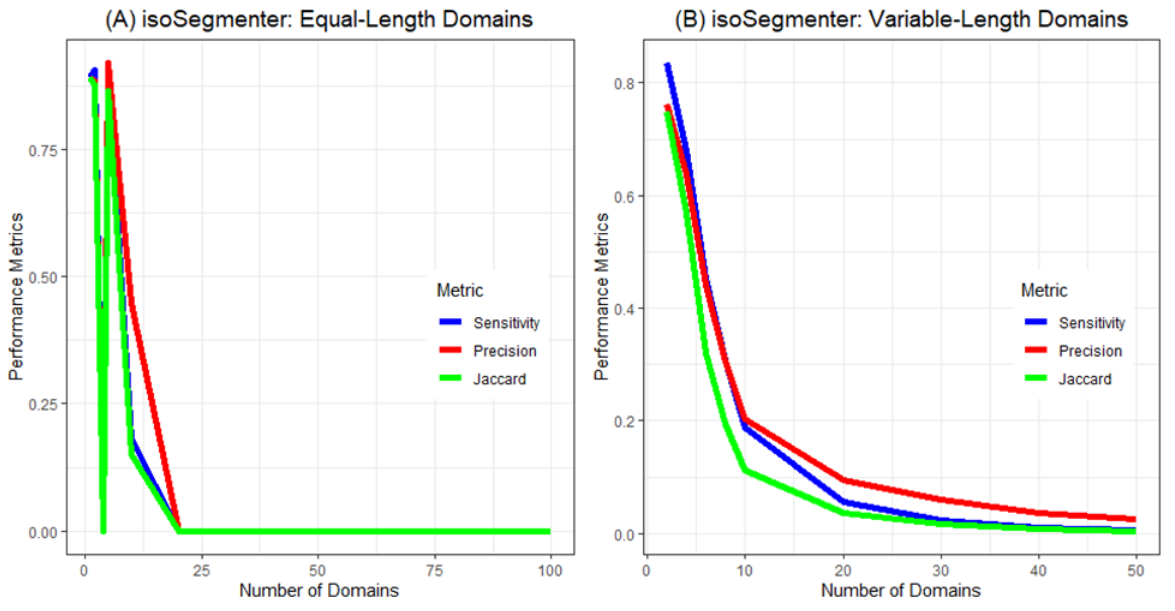
Figure 2. Performance metrics for isoSegmenter across numbers of equal-length domains ( A ) and variable-length domains ( B ).